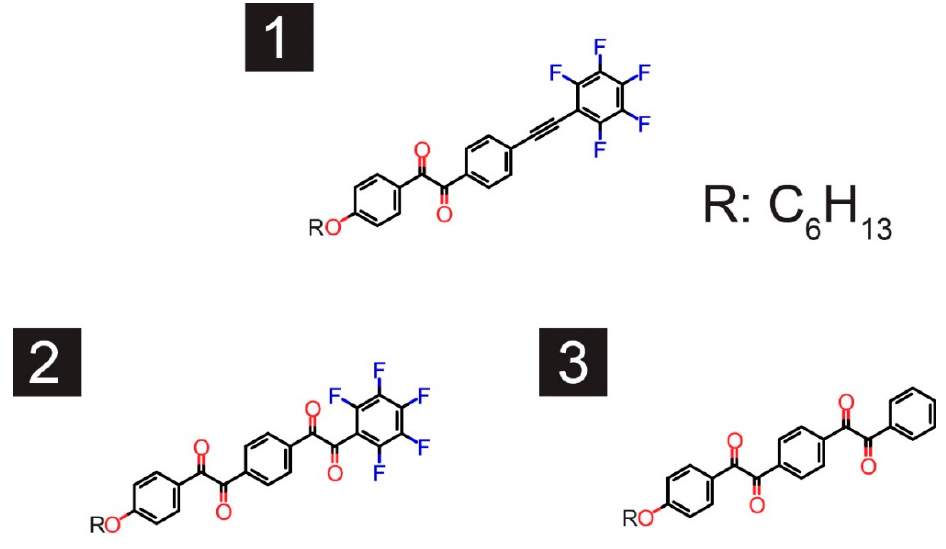
Figure 2. Fluorinated monobenzil ( 1 ), fluorinated bisbenzil ( 2 ) and non-substituted ( 3 ) bisbenzil